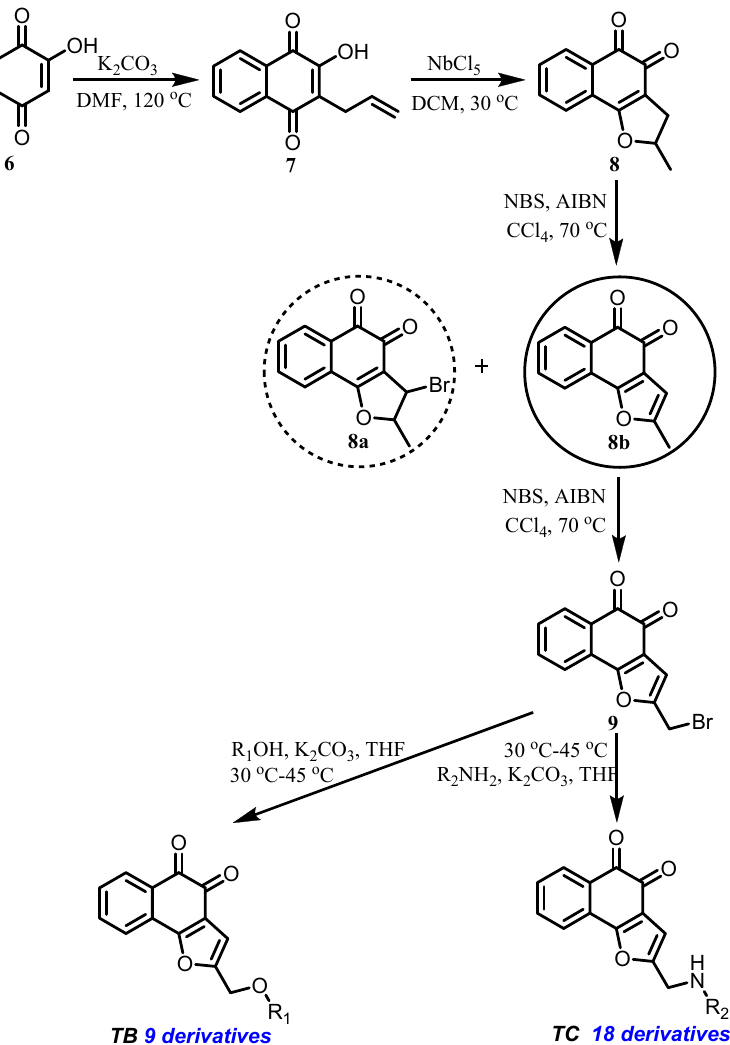
Scheme 1. Synthesis of L-shaped ortho-quinone analogs.